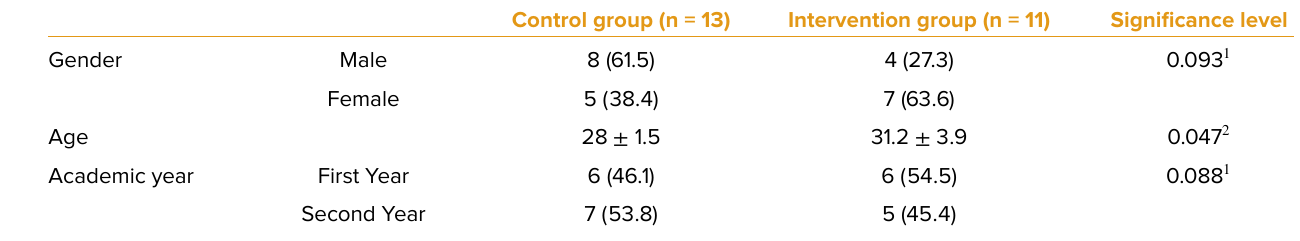
Table 2. The total scores of the groups studied in the pretest and posttest